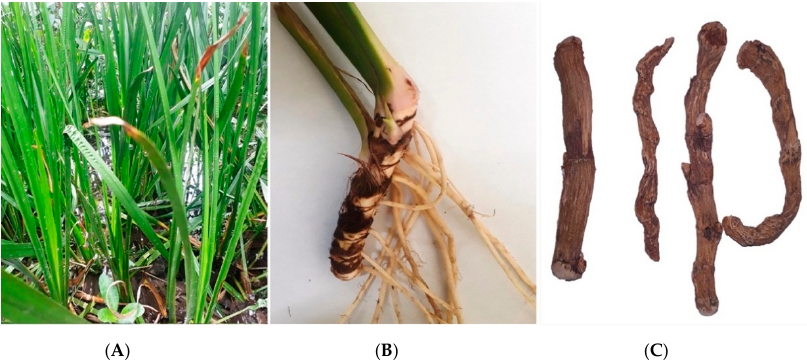
Figure 2. Photographs of Acorus calamus : ( A ) Natural habitat; ( B ) Fresh rhizome; ( C ) Dried rhizome .